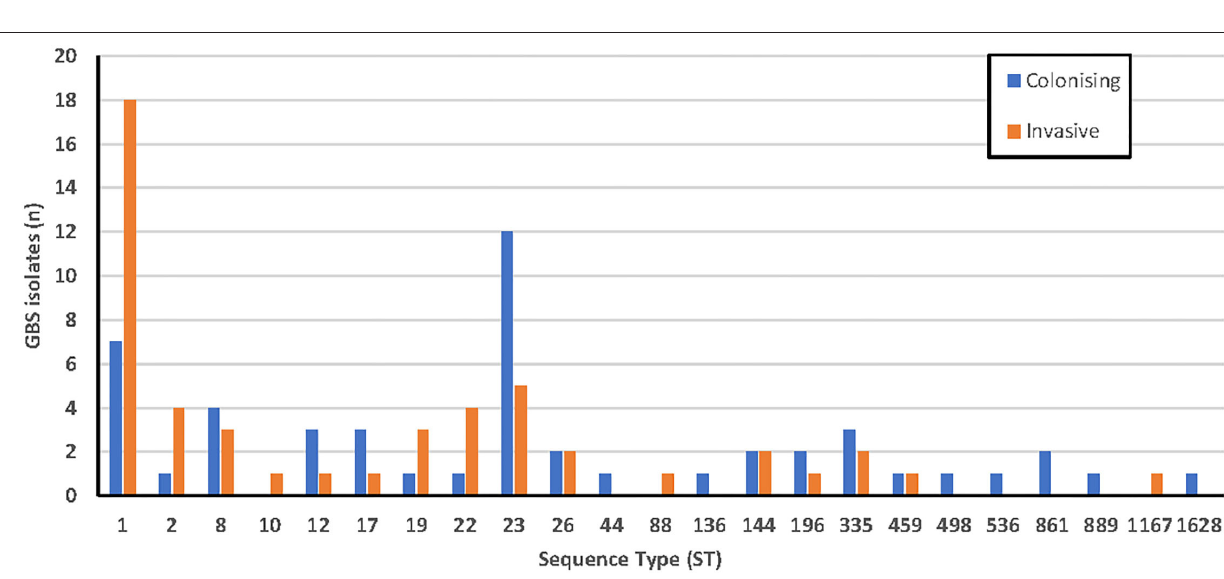
The virulence genes cfb, cylE, lmb, scpB and pavA were found in ≥ 99% isolates, and rib was not detected in any isolate. fbp was found in 63% isolates (34 invasive, 29 colonizing) with pairwise alignment ≥ 99.8%. hylB was found in 86% isolates (not found in six invasive, eight colonizing